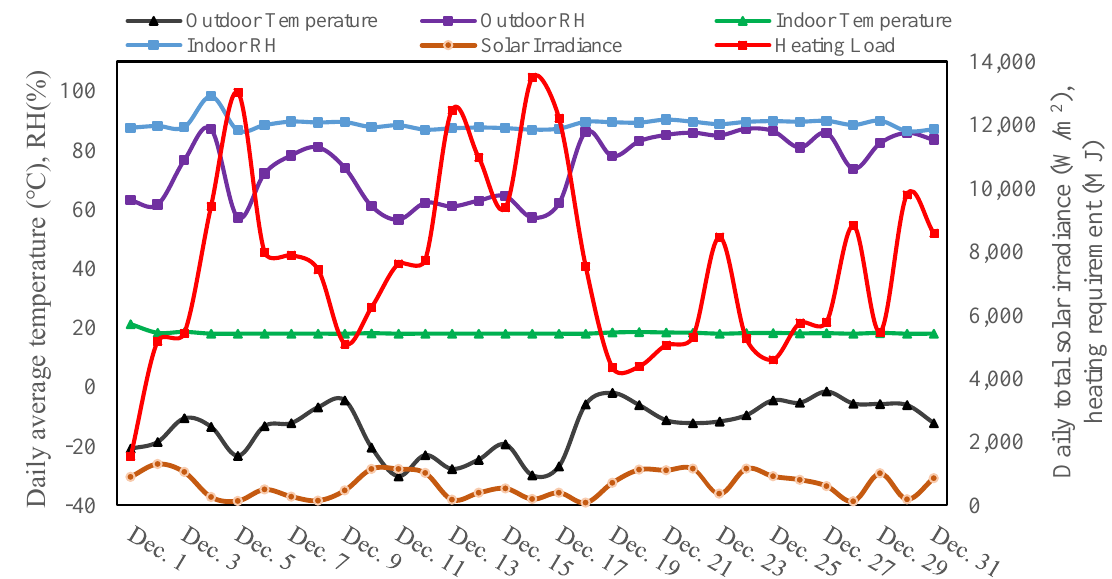
Figure 12. Daily average indoor conditions, solar irradiance, and heating loads in December. In July, as shown in Figure 14, the average daily indoor temperature ranged between 22 to 28 °C, and RH fluctuated in an extensive range due to the air exchange rate changing from infiltration at night to high ventilation rate during the daytime. The daily total solar irradiance was high, and a sun blocker is considered to protect the tomato plants. Supple- mental heating is not required except for the early morning on 25 July when the ambient temperature is below 10 °C, and the thermal blanket is rolled up.